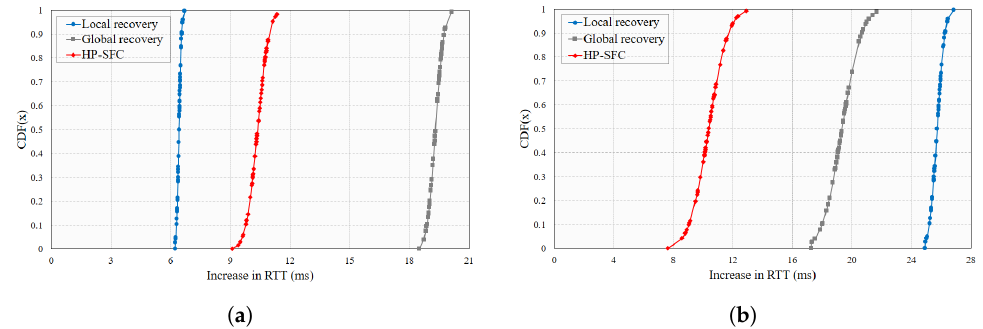
Figure 8. Enterprise topology, average RTT increment of SFCs 1, 3, and 8 for local recovery, global recovery, and HP-SFC protection mechanisms. ( a ) RTT increment for SFF-SFF link failure. ( b ) RTT increment for SF-SFF link